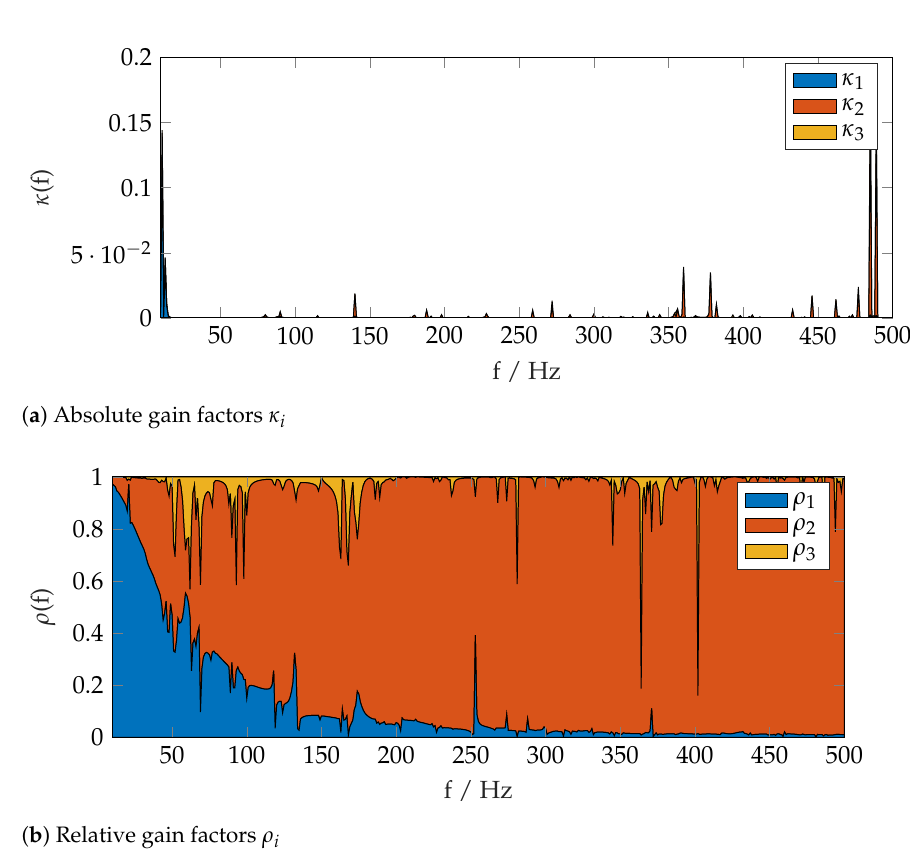
Figure 11. Frequency response gain factors in the range from 10Hz to 500Hz